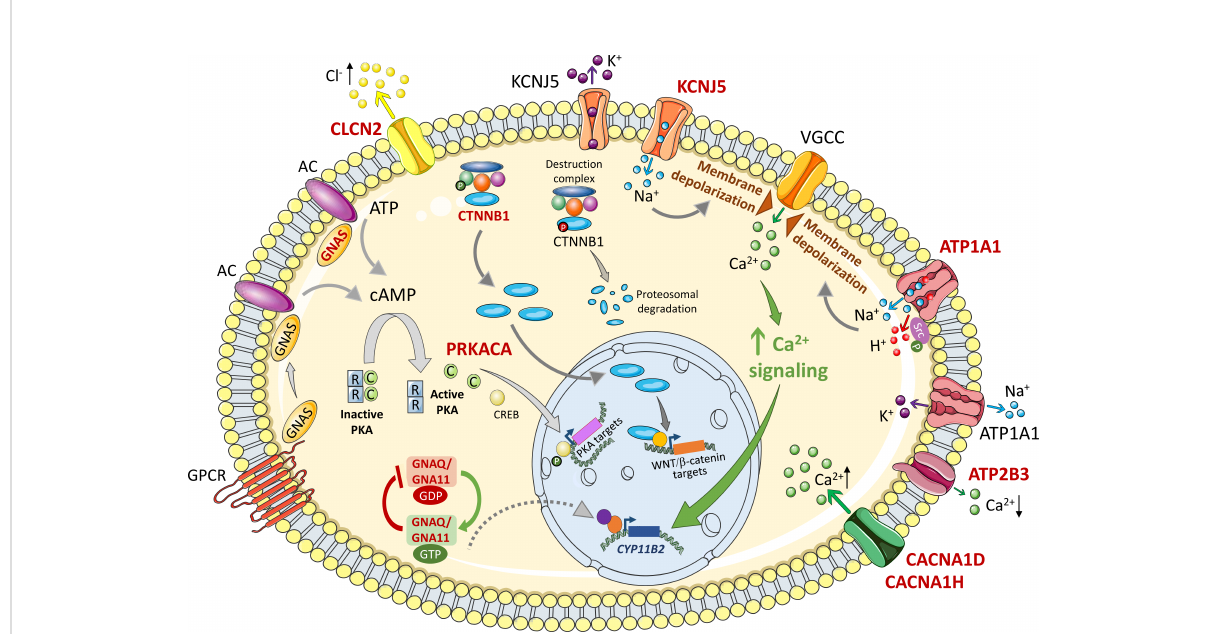
FIGURE 1 Mechanisms of deregulated cell growth of variants related to primary aldosteronism. The fi gure shows intracellular signaling pathways activated by APA somatic mutations implicated in cell growth mechanisms. Wild type and mutated forms are labeled in black and red respectively. Membrane depolarization triggered by Na+ or H+ in fl ux causes opening of voltage gated ion channels (VGCC), Ca2+ in fl ux and activation of Ca2+ signaling that activates CYP11B2 gene transcription to drive increased aldosterone biosynthesis and cell proliferation. ATP1A1 is also reported to activate cell proliferation by phosphorylated Src. Intracellular b -catenin concentrations are kept low under basal conditions by continuous proteosomal degradation. Activating mutations in exon 3 of the b -catenin gene bypass this control mechanism resulting in cytoplasmic b -catenin accumulation and nuclear translocation to activate speci fi c gene transcription programs. In many adrenal tumours including some rare APA examples, cAMP/PKA signaling is activated by mutations in GNAS and PRKACA for activation of target genes. GNAQ and GNA11 mutations can cause upregulated aldosterone production in vitro and are associated with hyperplasia of glomerulosa cells adjacent to an APA. They are clinically silent in vivo except when concomitant with CTNNB1 ( b -catenin) mutations. See text for details. Somatic mutations in CLCN2, CACNA1D, CACNA1H, and ATP2B3 have been described in APAs which result in increased Cl- ef fl ux (CLCN2), increased Ca2+ in fl ux (CACNA1D, CACNA1H), and decreased Ca2+ ef fl ux (ATP2B3). AC, adenylyl cyclase; ATP, adenosine triphosphate; ATP1A1, ATPase Na +/K+ transporting subunit a 1; ATP2B3, ATPase plasma membrane Ca2+ transporting 3; C, catalytic subunit; CACNA1D, calcium voltage-gated channel subunit alpha1 D; CACNA1H, calcium voltage-gated channel subunit alpha1 H; cAMP, cyclic adenosine monophosphate; Ca2+, calcium ions; CLCN2, chloride voltage-gated channel 2; CREB, cAMP response element-binding protein; CYP11B2, cytochrome P450 family 11 subfamily B member 2 (aldosterone synthase); GDP, guanosine diphosphate; GNA11, G protein subunit a 11; GNAS, GNAS complex locus; GNAQ, G protein subunit a Q; GTP, guanosine triphosphate; GPCR, G protein coupled receptor; H +, hydrogen ions; K+, potassium ions; KCNJ5, potassium inwardly rectifying channel subfamily J member 5; Na+, sodium ions; PKA, protein kinase A; PRKACA, protein kinase cAMP-activated catalytic subunit a ; R, regulatory subunit; VGCC, voltage-gated calcium channel; WNT, wingless-related integration site. Figure produced using Servier Medical Art